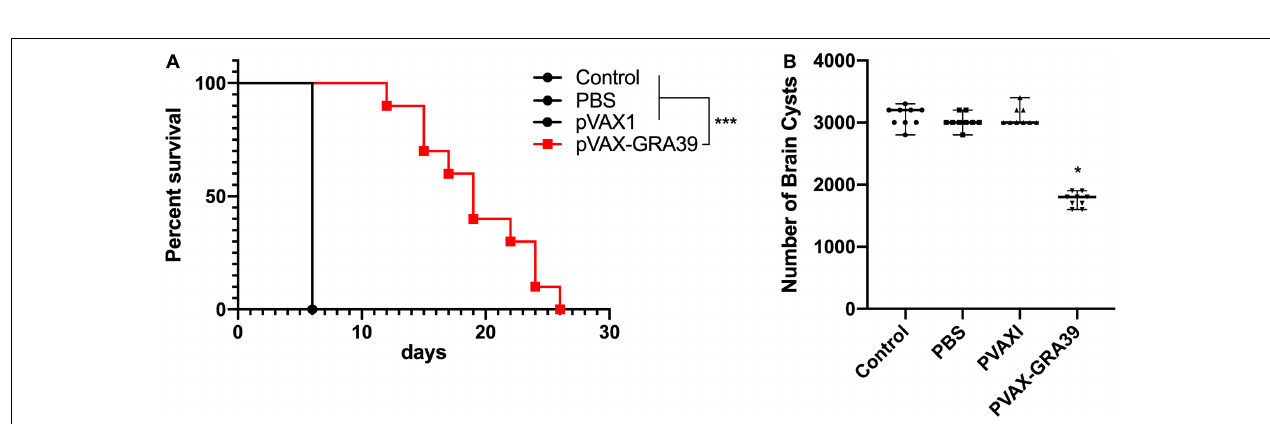
FIGURE 8 | Protective efficacy of mice immunized with pVAX-GRA39 (A) Survival curves of Kunming mice after challenge of T. gondii RH strain. The mice (10 per group) in all groups were challenged with 1 × 10 3 tachyzoites of the virulent T. gondii RH strain intraperitoneally. Three control groups (PBS, pVAX I and blank control) had 0% survival at day 6. Immunized groups have prolonged survival time of mice. (B) Protection against chronic toxoplasmosis in immunized mice two weeks after the last booster immunization. The bars represented the mean cyst burden per mouse brain after oral challenge with a dose of 10 cysts of the Pru strain. Cyst load was counted from whole brain homogenates of mice 4 weeks after challenge. Data are mean ± SDs (representative of three experiments). * p < 0.05, *** p < 0.001 compared with the control groups.